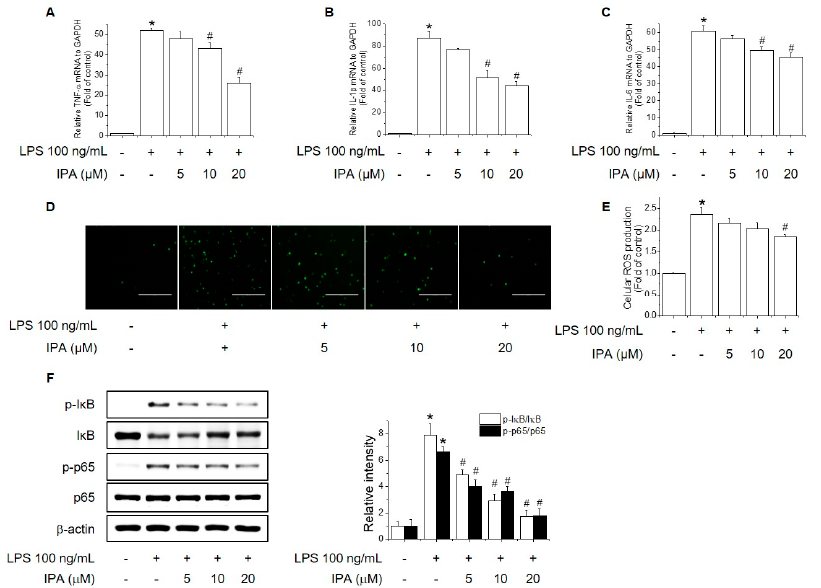
Figure 2. Effect of IPA on LPS-induced pro-inflammatory cytokine and ROS levels. ( A – C ) RAW264.7 cells were pretreated with 5–20 μ M IPA for 12 h, 100 ng/mL LPS for 6 h, and TNF- α ( A ), IL-1 β ( B ), and IL-6 ( C ) expression was analyzed by real-time PCR. ( D , E ) RAW264.7 cells were pretreated with 5–20 μ M IPA for 12 h and 100 ng/mL LPS for 24 h. ROS levels measured by H 2 DCF-DA. ( F ) Effect of IPA on LPS-induced phosphorylation of I κ B and NF- κ B. RAW264.7 cells were pre- treated with 5–20 μ M IPA for 12 h followed by 100 ng/mL LPS for 1 h. * Significantly different from the control at p < 0.01. # Significantly different from the LPS treatment group at p < 0.01.